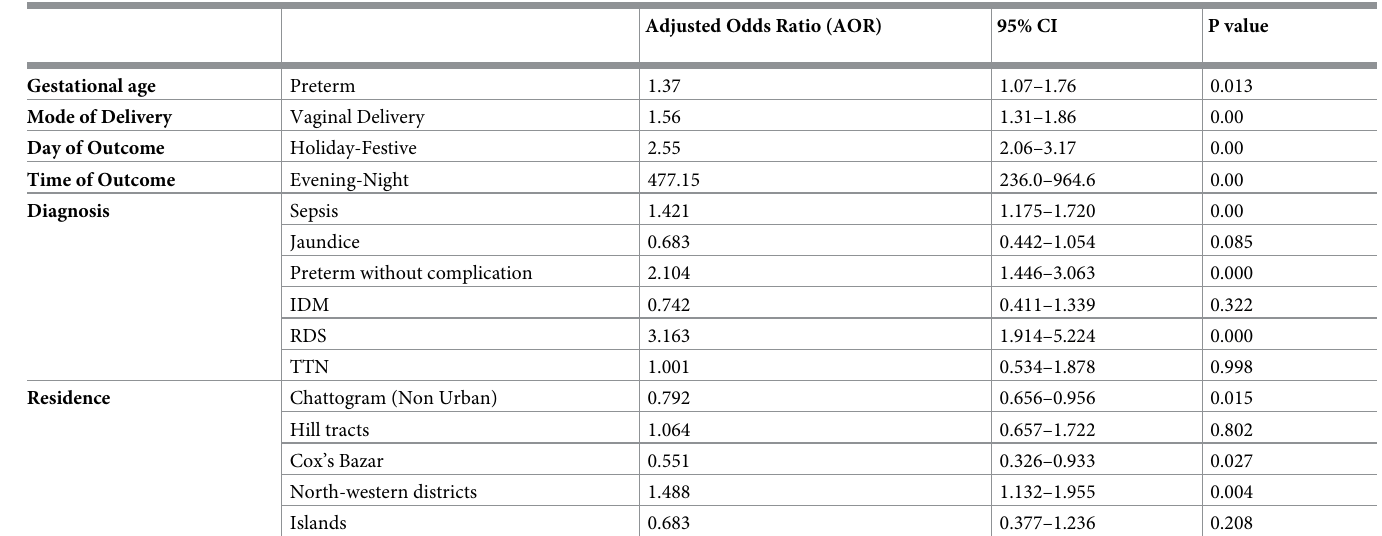
Table 4. Logistic regression to analyze the influence of independent